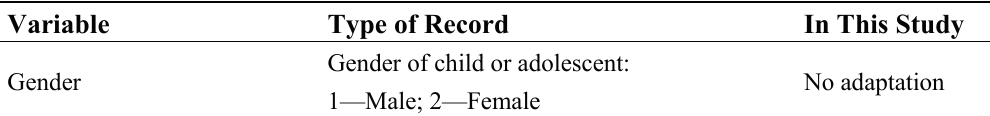
Table 1. Categorization of